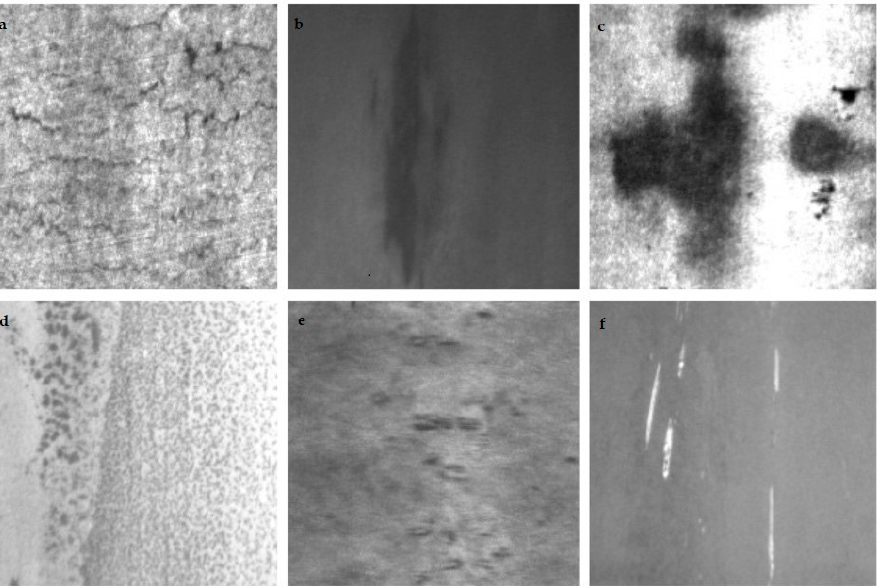
Figure 1. Different types of steel surface defects. ( a ) Crazing, ( b ) inclusion, ( c ) patches, ( d ) pitted surface, ( e ) rolled-in scale, ( f ) scratches.